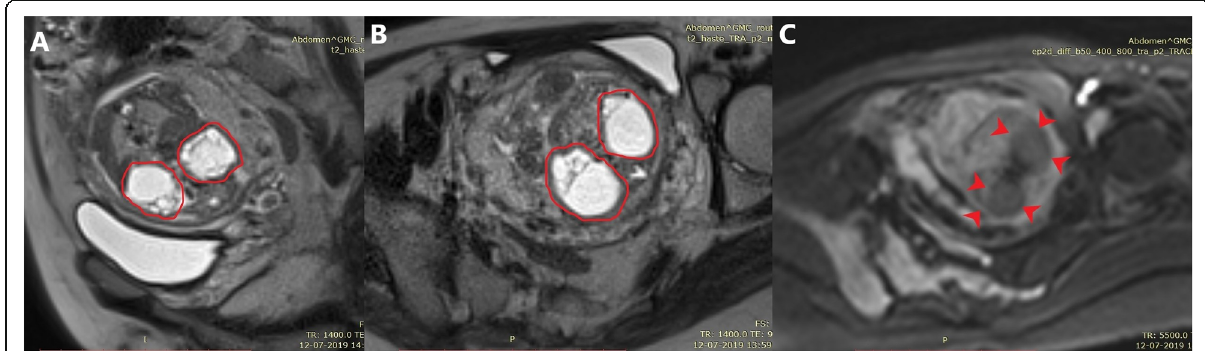
Fig. 2 Bilateral multicystic dysplastic kidney disease: maternal age: 20 years; period of gestation: 21 weeks 2 days: T2 HASTE coronal ( a ) and axial ( b ) images show multicystic dysplastic changes involving both kidneys (red tracing) with associated anhydramnios. Axial DWI ( c ) shows loss of normal hyperintense signal in both kidneys (arrowheads)